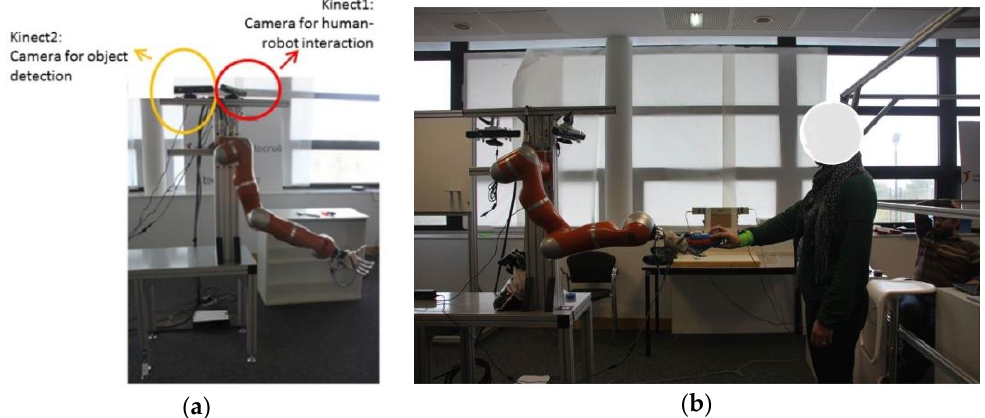
Figure 4. ( a ) Kuka Lightweight Robot (LWR) arm provided with cameras; ( b ) object exchange between robot and human.